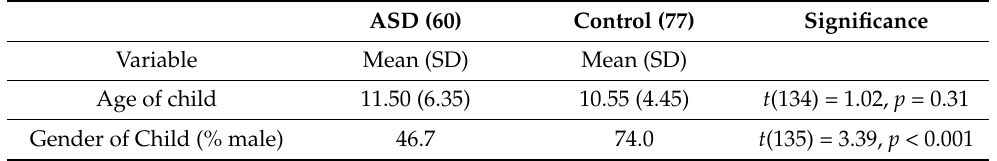
Table 1. Age and gender for the ASD and control group.